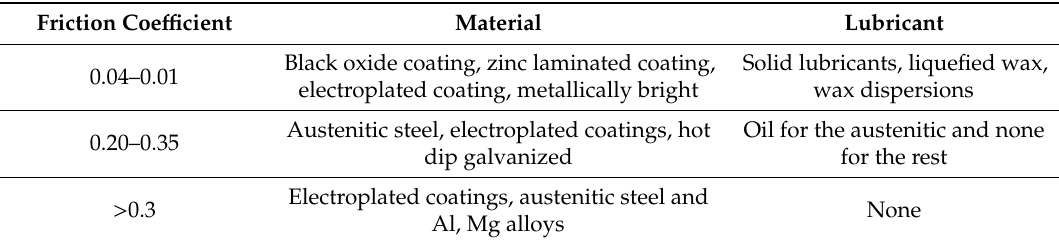
Table 2. Friction coefficient values for different lubricants, data from [17].